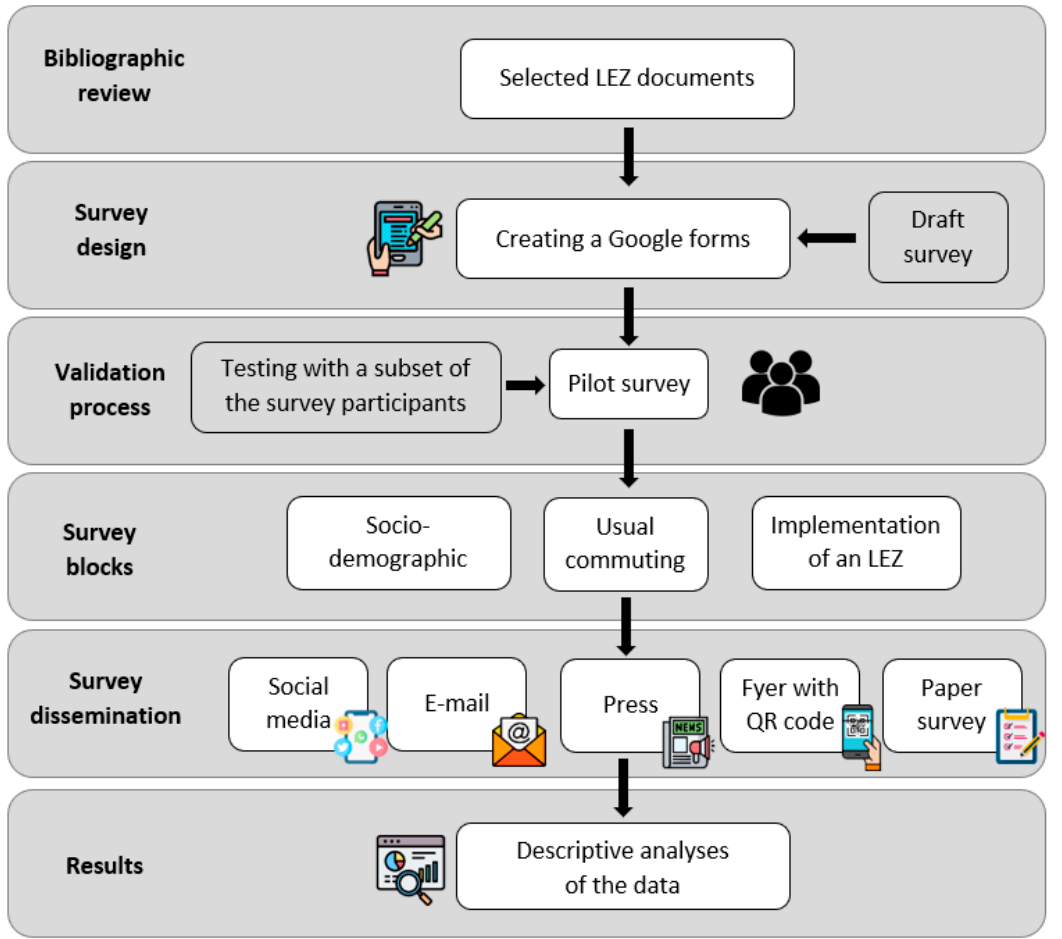
Figure 2. Methodology flowchart.